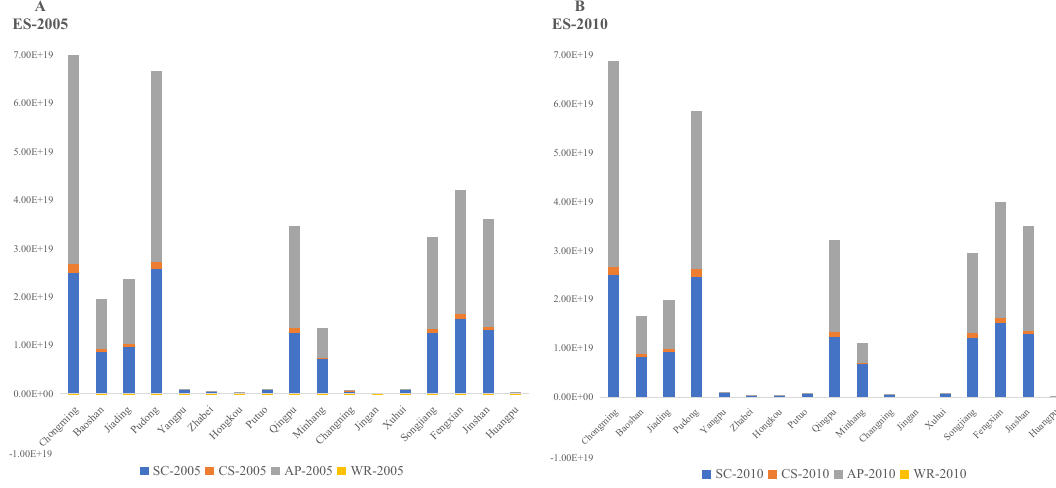
Figure 11. ESs values at the district level in Shanghai (sej/yr). ( A ): ESs value in 2005 at the district level; ( B ): ESs value in 2010 at the district level.